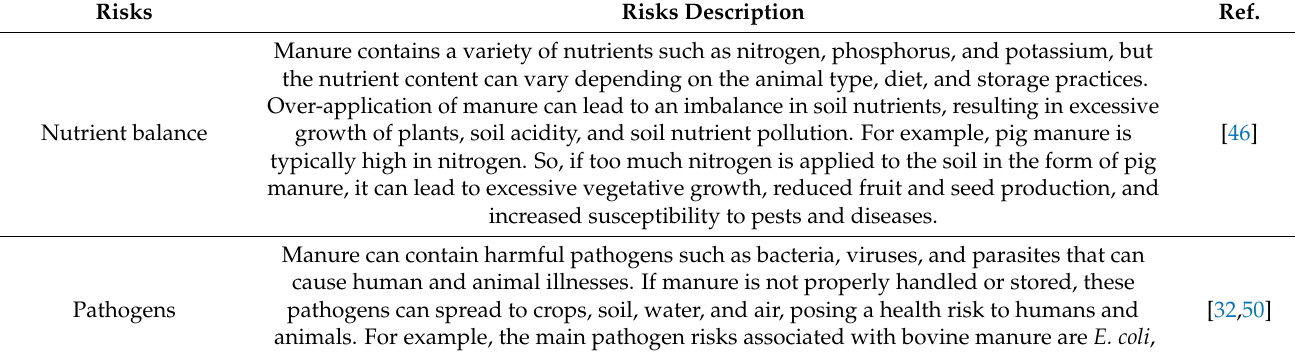
Table 1. Some of the risks related to the use of manure as a soil amendment. Risks Description Ref.